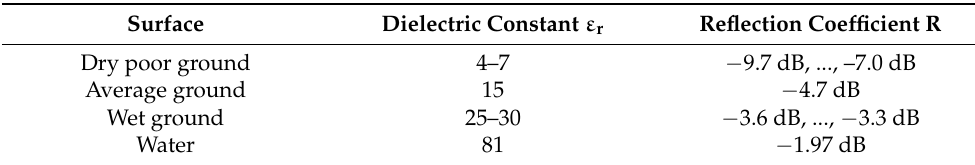
Table 4. Reflection Coefficients for Typical Ground Types.